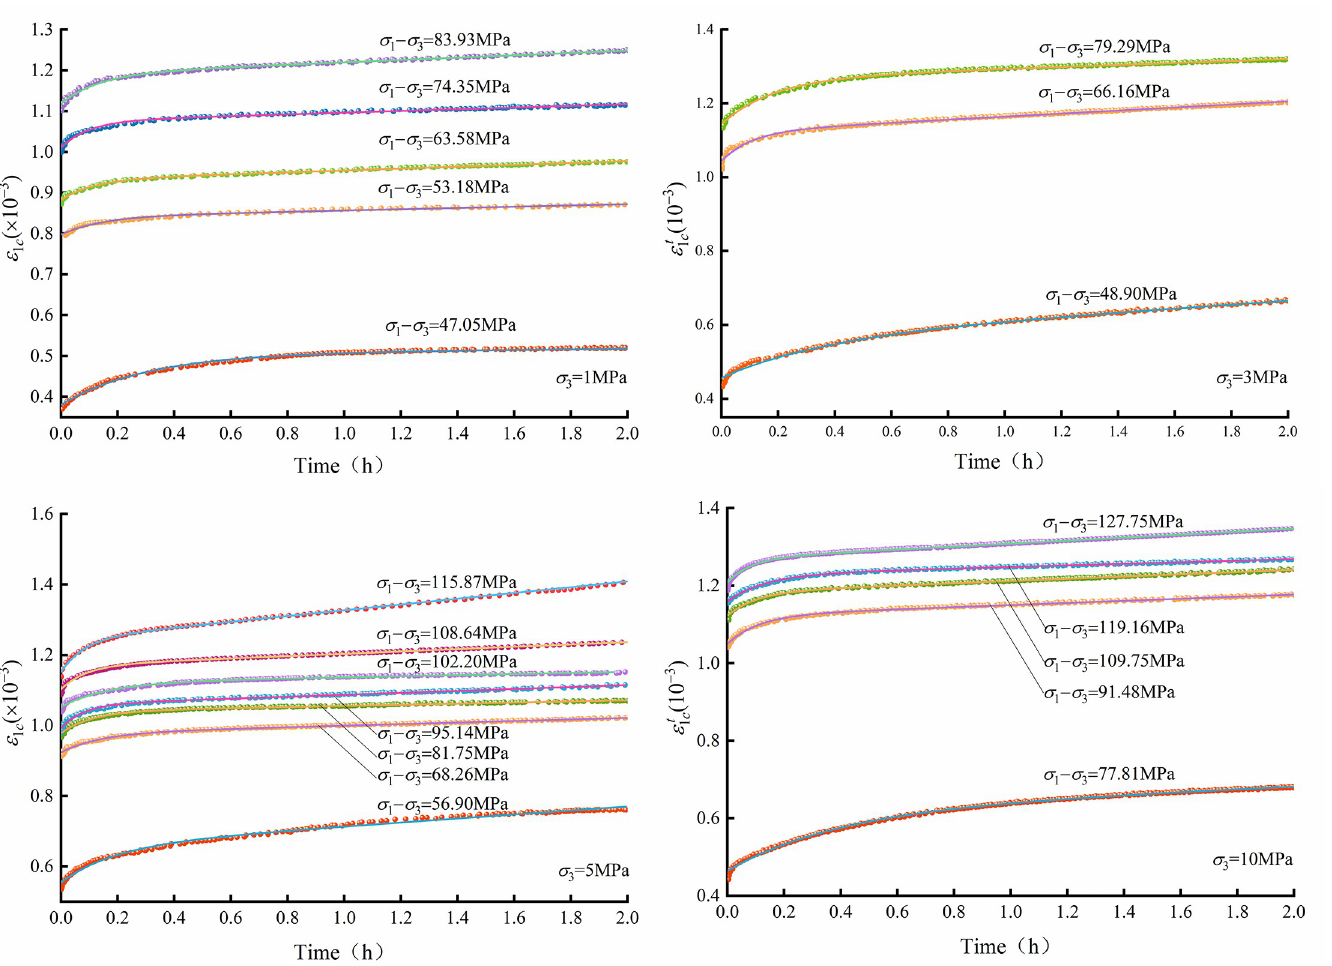
Fig 17. Axial creep crack strain results of micritic bioclastic limestone from triaxial multicreep tests and equation fitting. Note: line stands for fitting curve, and dots stand for test